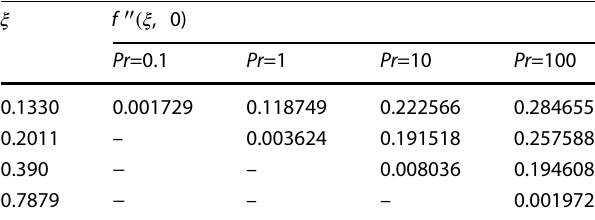
Table 8 Effect of Pr and 𝜉 on f �� ( 𝜉 ,0 ) profile near separation point ( 𝜆 < 0 ) for 𝜙 =0.05